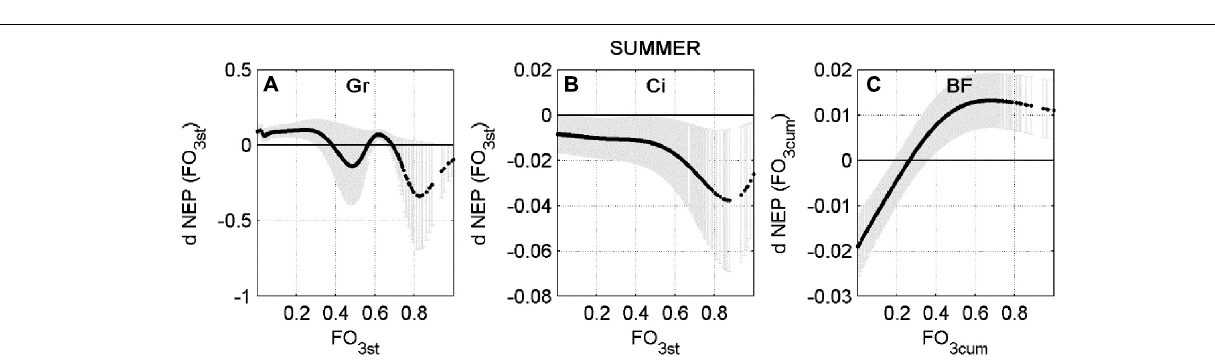
FIGURE 3 | Average partial derivative of NEP (dNEP) with respect to the corresponding input variable (FO 3st or FO 3CUM ) ± standard deviation, calculated using Summer data. (A) Grignon (Gr), (B) Lindcove (Ci), (C) Bosco Fontana